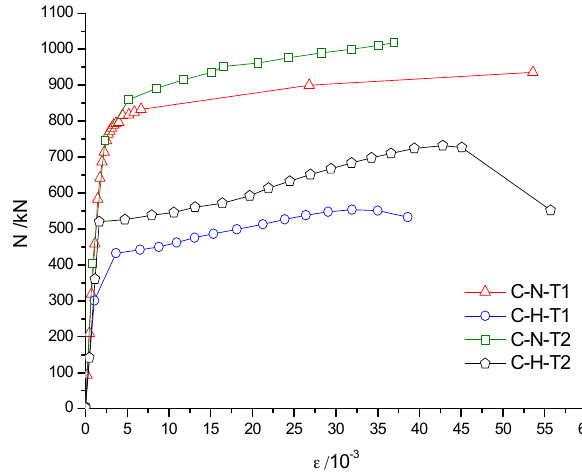
Figure 14. Influence of wall-thickness on N- ε curves.